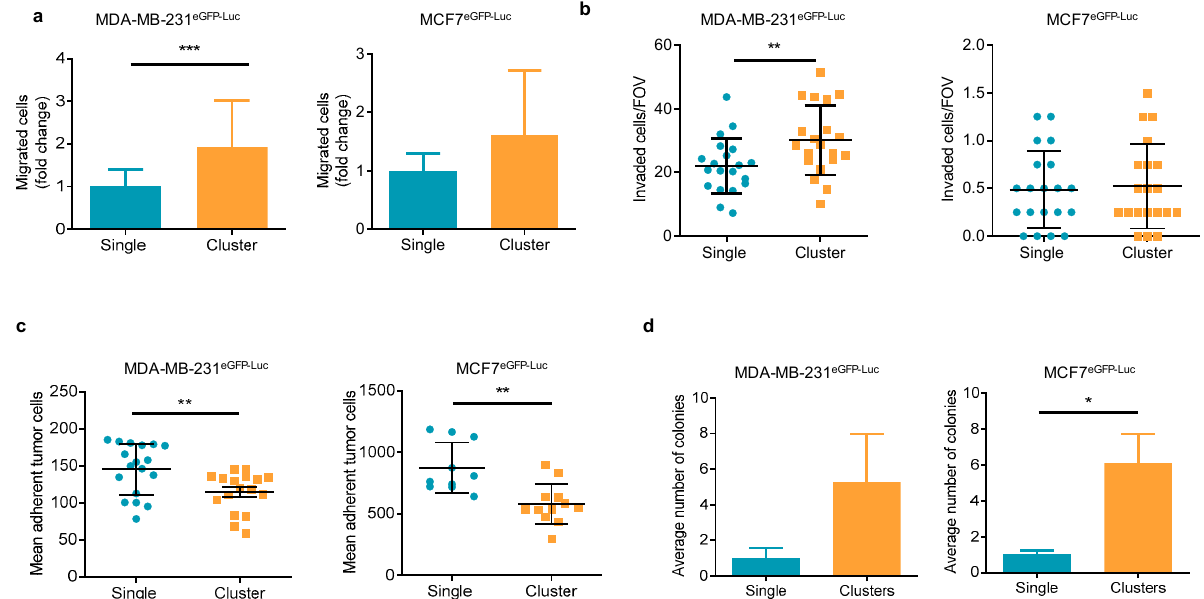
Figure 1. In vitro functional characterization of single CTC and CTC-cluster models. ( a ) Migration of single and cluster models derived from MDA-MB-231 eGFP-Luc ( n = 6) and MCF7 eGFP-Luc ( n = 4) cell lines. Data are expressed as the fold change of migrated cells relative to the migration observed in the single cell population; ( b ) Number of invaded MDA-MB-231 eGFP-Luc ( n = 3) and MCF7 eGFP-Luc ( n = 2) cells per field of view (FOV); ( c ) In vitro adhesion to endothelium of MDA ‐ MB ‐ 231 eGFP ‐ Luc ( n = 4) and MCF7 eGFP ‐ Luc ( n = 2) cells. Data are expressed as the average of adhered cells per well; ( d ) Average number of colonies generated by MDA ‐ MB ‐ 231 eGFP ‐ Luc ( n = 3) and MCF7 eGFP ‐ Luc ( n = 3) cells in the soft agar colony formation assays. Data are represented as the average number of colonies. * p < 0.05, ** p < 0.01, *** p < 0.001.